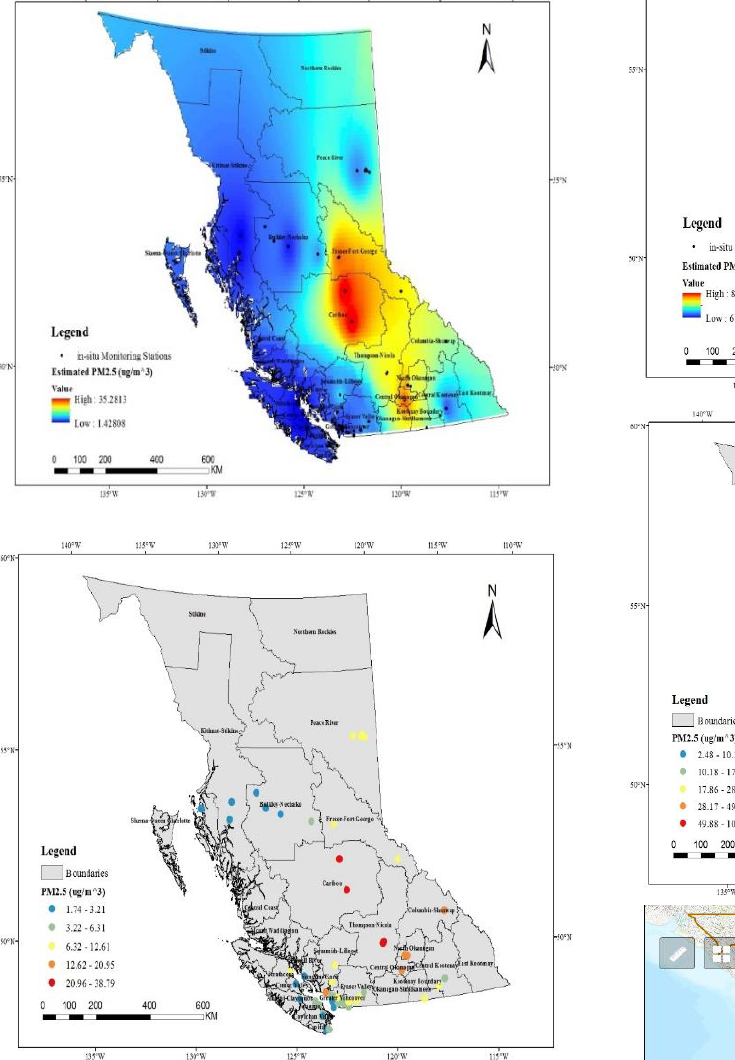
Fig. 7. Estimated PM 2.5 generated by the GWR model in July (top); averaged PM 2.5 concentrations from ground monitoring stations in July (bottom).